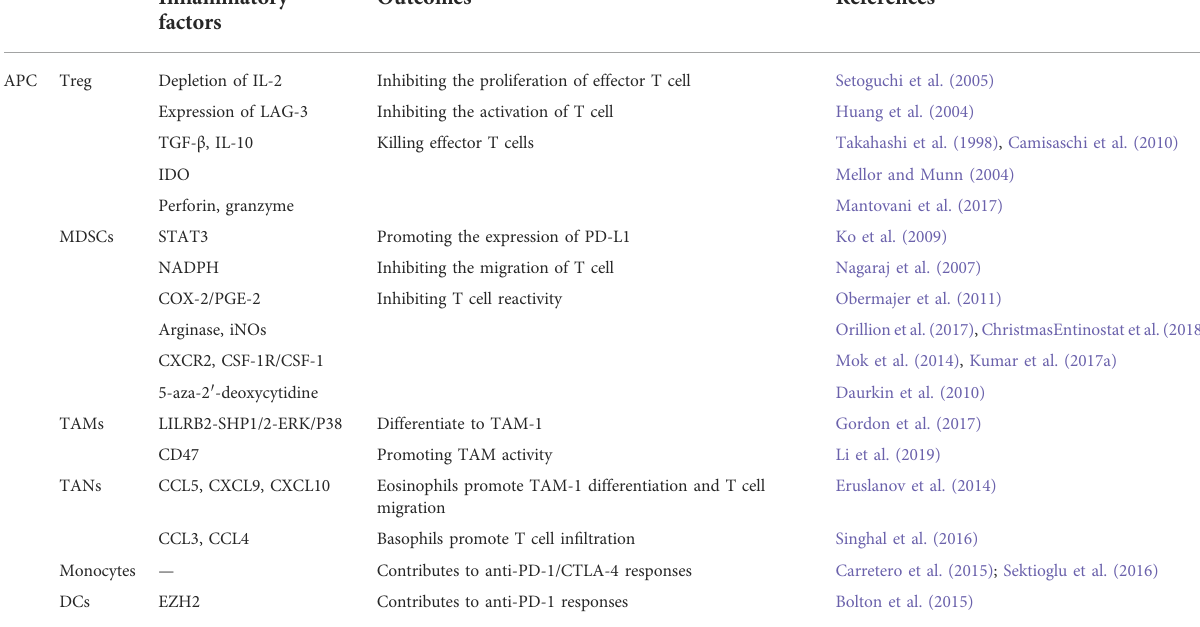
TABLE 1 Regulation of TIL in fi ltration by Regulatory immune